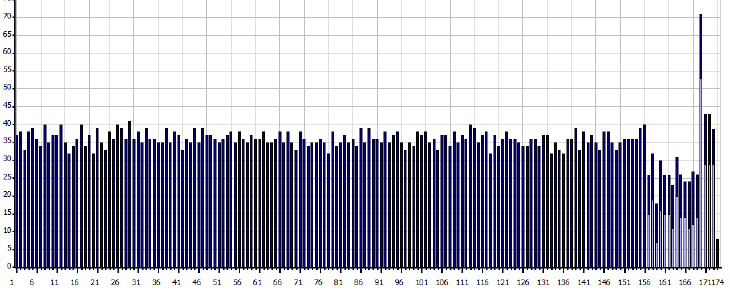
Figure 11. Total packets queued—WiFi.